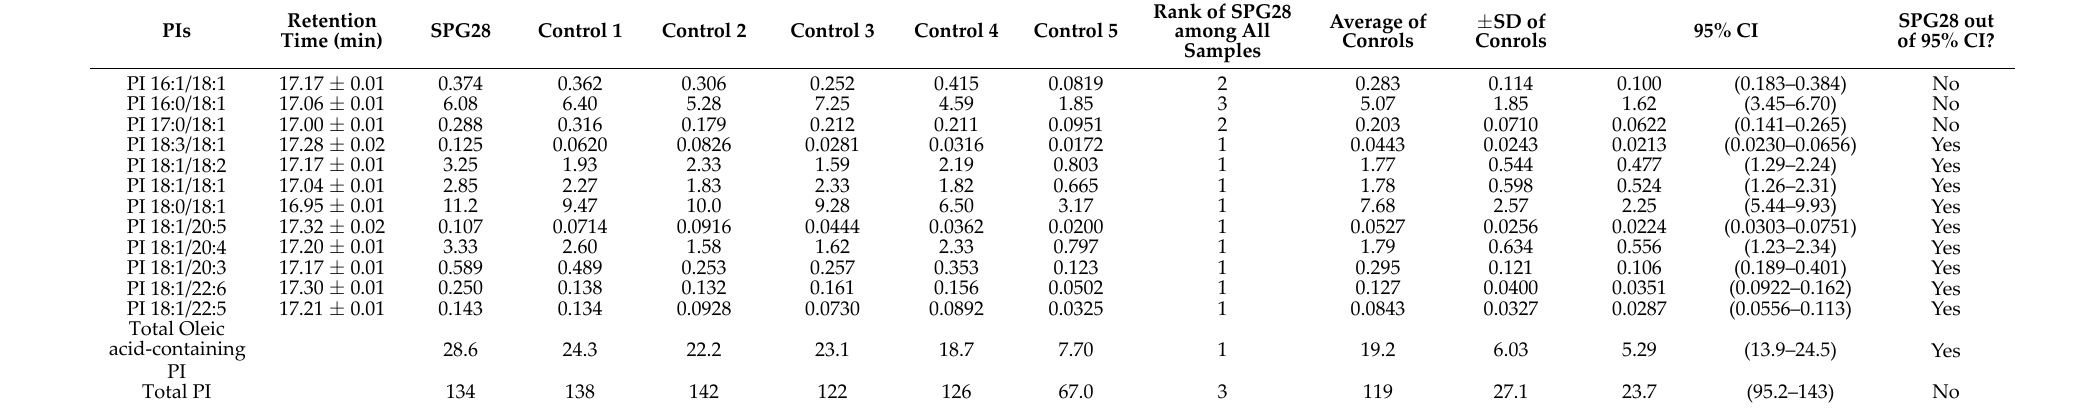
Table 5. Oleic acid‑containing PIs in human